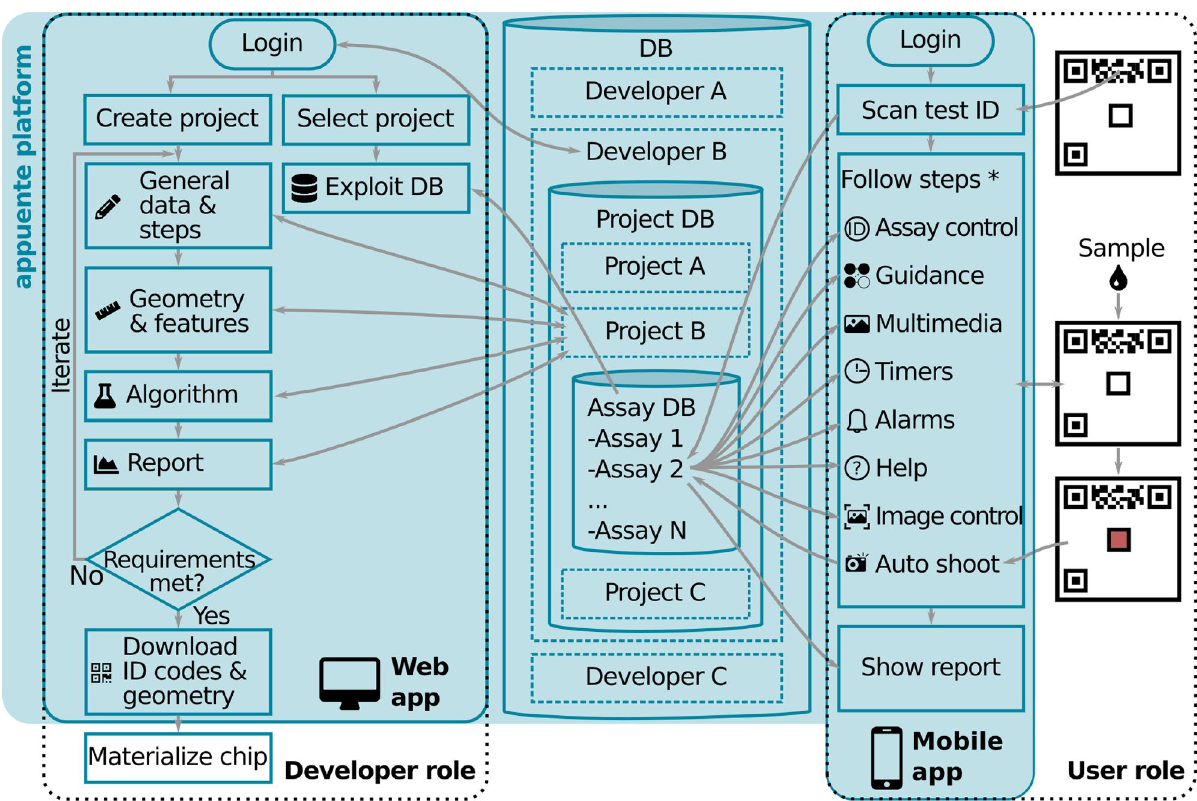
Figure 2. Representation of the typical flow diagram followed by appuente developers and users and interactions through the database (DB). (*) Note that after the ID code scan, the specific steps to be followed depend on the project; thus, the “Follow steps” box enumerates a subset of the offered